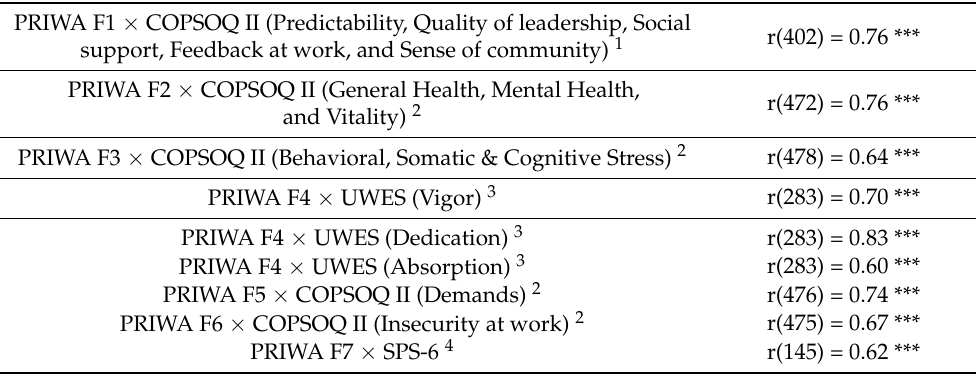
Table 6. Pearson’s Correlation Coefficients between PRIWA scales and COPSOQ II, EAS, and SPS-6